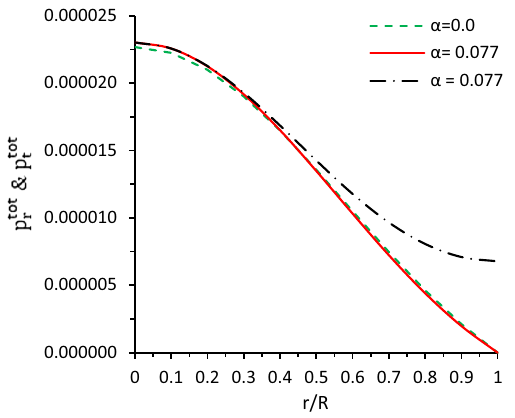
Fig. 11 The behavior of different forces F tot g (solid lines), F tot dash-dotted lines), F tot a (small dash-dotted lines) and F tot e (long dashed lines) versus radial coordinate r / R by taking the numerical values of the constants a = 0 . 003, b = 0 . 0000053, β = 1 . 1, and γ = − 0 . 001